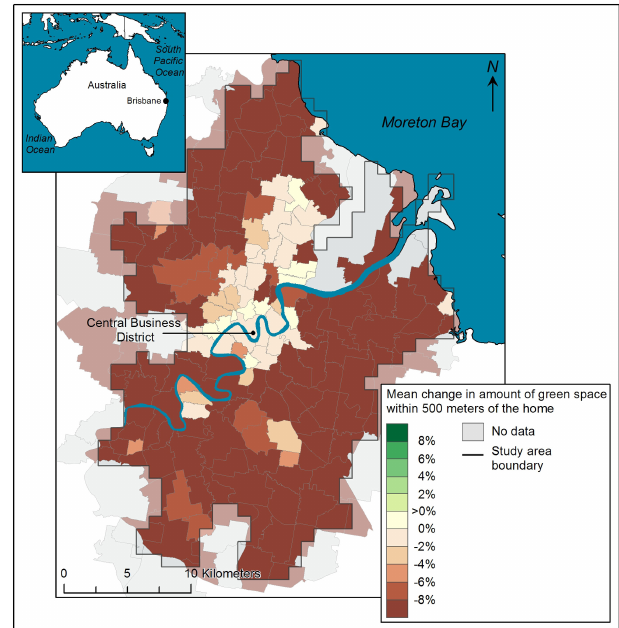
Fig. 3 . Mean proportional change in the total area covered by public green space (m²) within a 500 meter radius of the home for each suburb across the city under the sprawling urban growth scenario. There was no change in the amount of green space in the city between the current scenario and the future compact development scenario so no data are shown for the compact development scenario. Suburbs with a mean increase or no change in public green space area within 500 meters of the home are colored dark to light green while suburbs with a mean decrease in public green space area within 500 meters of the home are colored light to dark